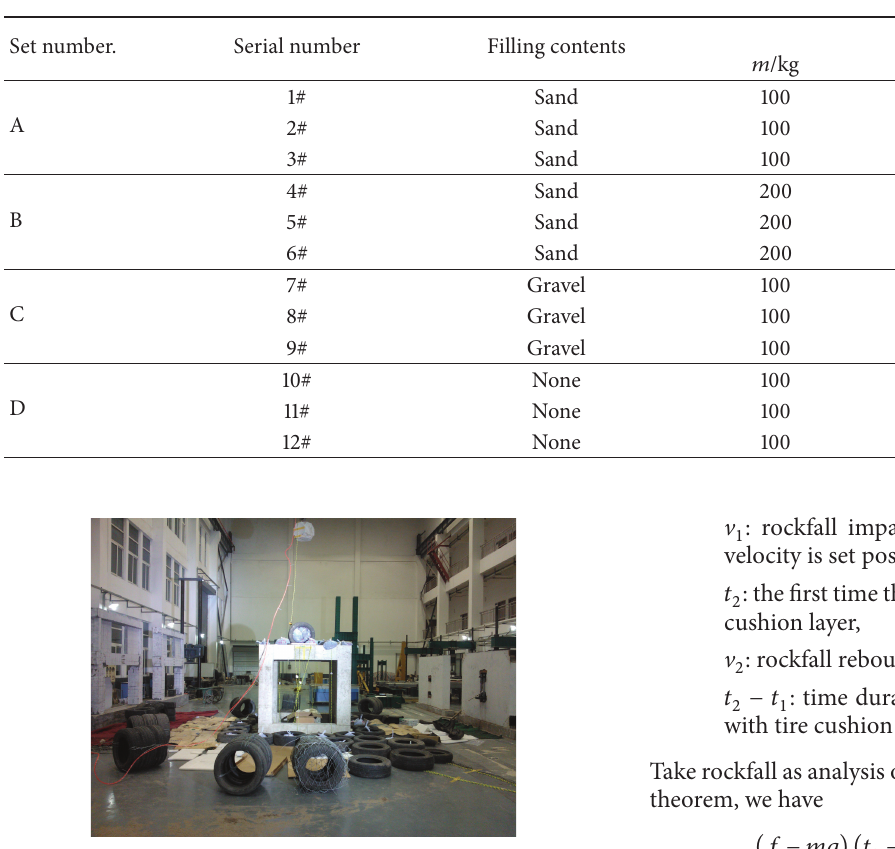
Table 1: Test conditions.